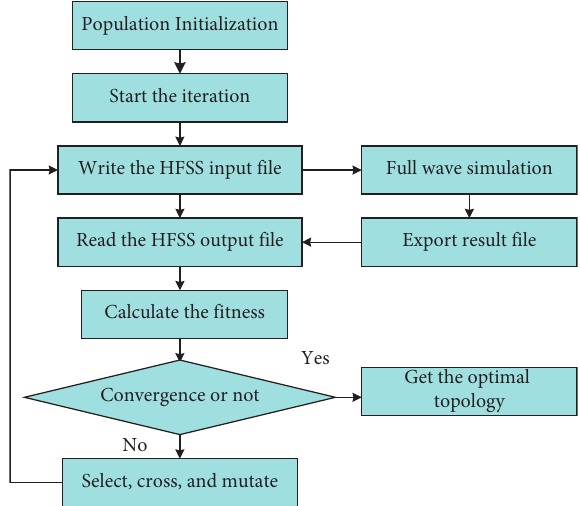
Figure 4: The topology optimization process of the